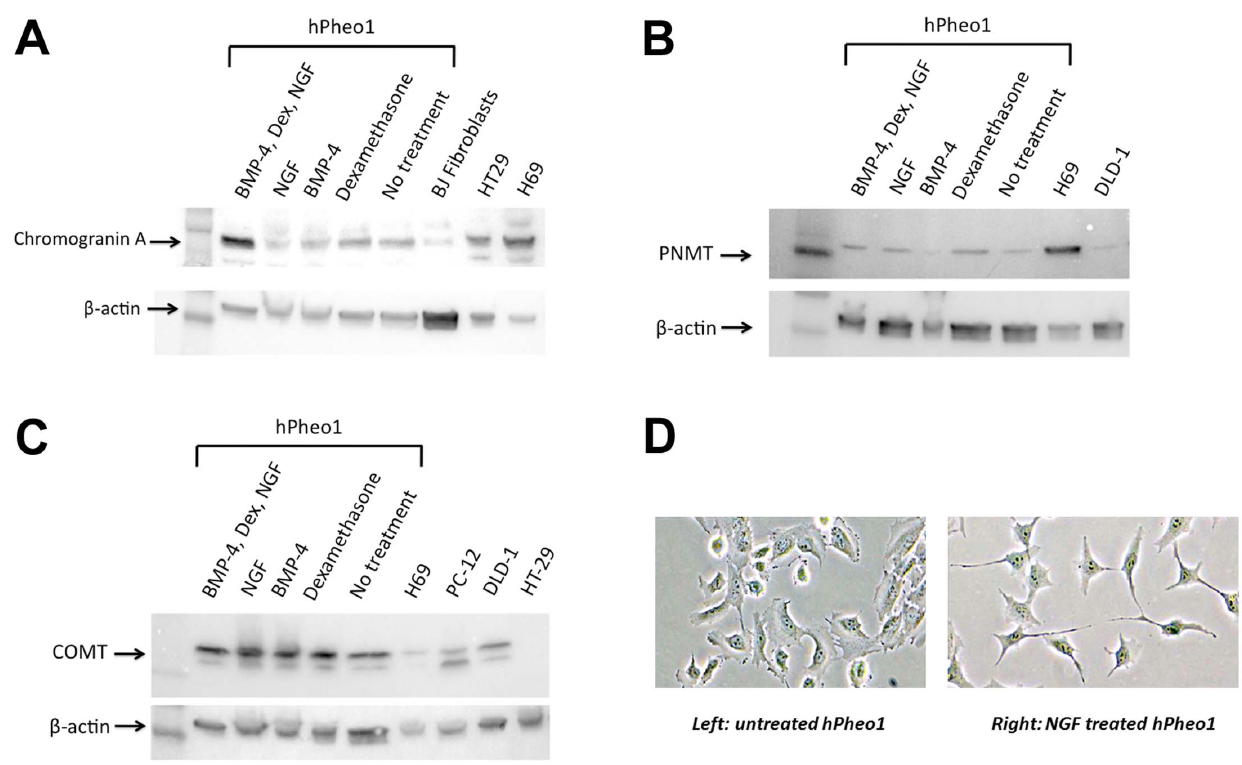
Figure 2. Differentiation of hPheo1 cells. A. Western blot for chromogranin A shows expression more prominent after differentiation treatment. B. Western blot for PNMT shows expression more prominent after differentiation treatment. C. Presence of COMT in hPheo1 cells is seen, whether treated with differentiating factors or not. D. Neurite formation in hPheo1 cells occurs after treatment with Nerve Growth Factor (NGF). doi:10.1371/journal.pone.0065624.g002 protein/well. Proteins were resolved with 10% SDS-PAGE and 1 hour at 86 volts. The membrane was washed with TTBS transferred to PVDF membranes (Immobilon-P, Millipore) over